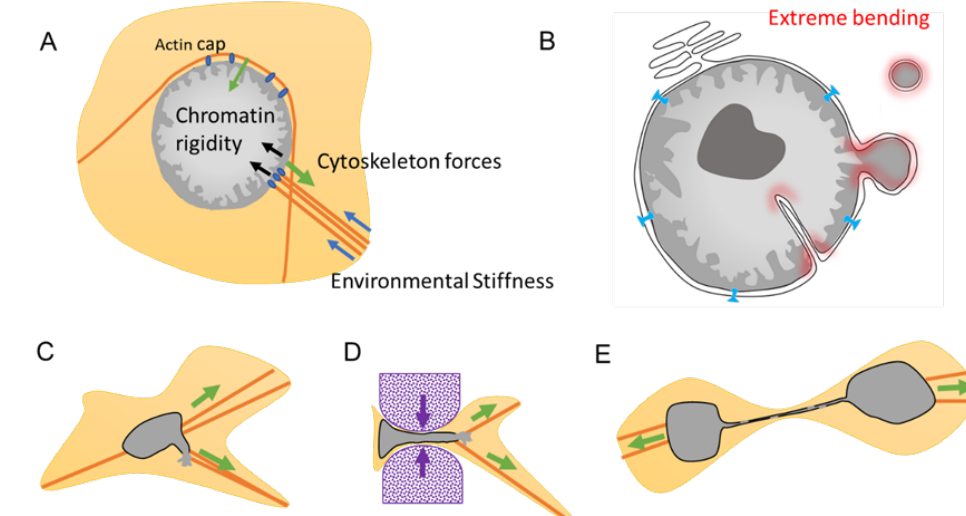
Figure 5. Nuclear envelope (NE) equilibrium and cases of nuclear envelope disruption (NED). ( A ). NE homeostasis between the chromatin rigidity forces (black arrow), cytoskeleton forces (green arrow), and the effect of the environment stiffness (blue arrow). Mechanosensitivity of the NE is done through the connection of the cytoskeleton by the LINC complex (blue ovals). ( B ). Example of nucleus with several NE abnormalities leading to extreme NE curvature at invagination, blebbing, or on the NE of the micronuclei that might be involved in NE fragility (highlighted in red). ( C ). Cells under migration have strong cytoskeleton attraction that can lead to local tension and the formation of nuclear envelope disruption. ( D ). Cells in migration through tiny constrictions also endure new stiffness forces and will deform NE locally to ensure the nuclear passage and create new NE tension and extreme NE bending, leading to NED. ( E ). Two daughter cells experiencing telomere fusion have their nucleus connected by a chromatin bridge and sharing the same NE. The need of extra NE to cover the extended NE surface leads to NE weakness and break.